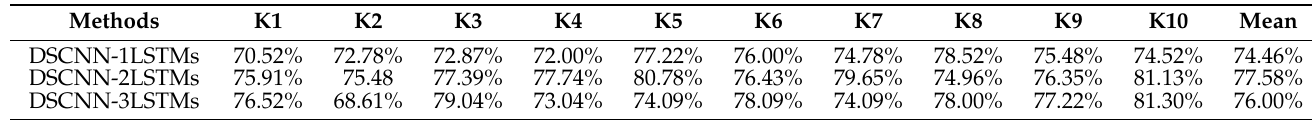
Table 3. The performance of DSCNN-1LSTM, DSCNN-2LSTM, and DSCNN-3LSTM model on the five-class classification